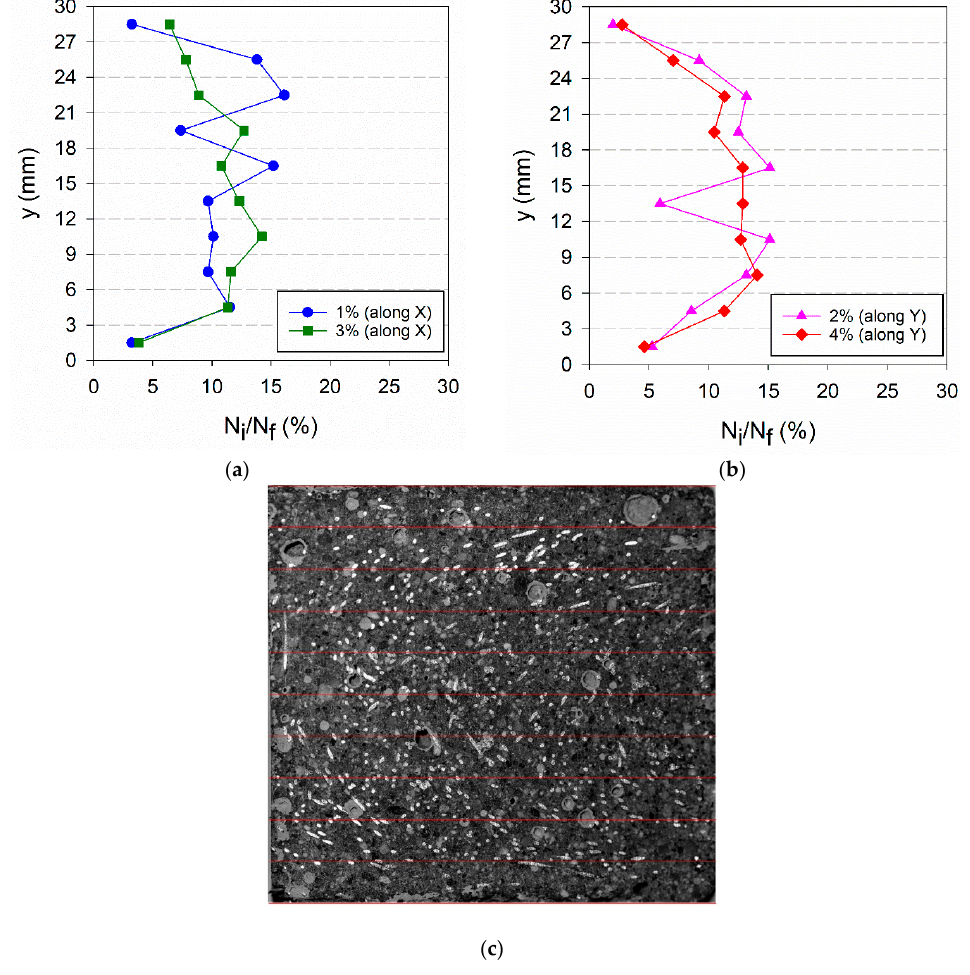
Figure 19. Fibre distribution along the plate thickness for VR_i specimens: ( a ) along X-direction, ( b ) along Y-direction; ( c ) image of VR_4% along X-direction.